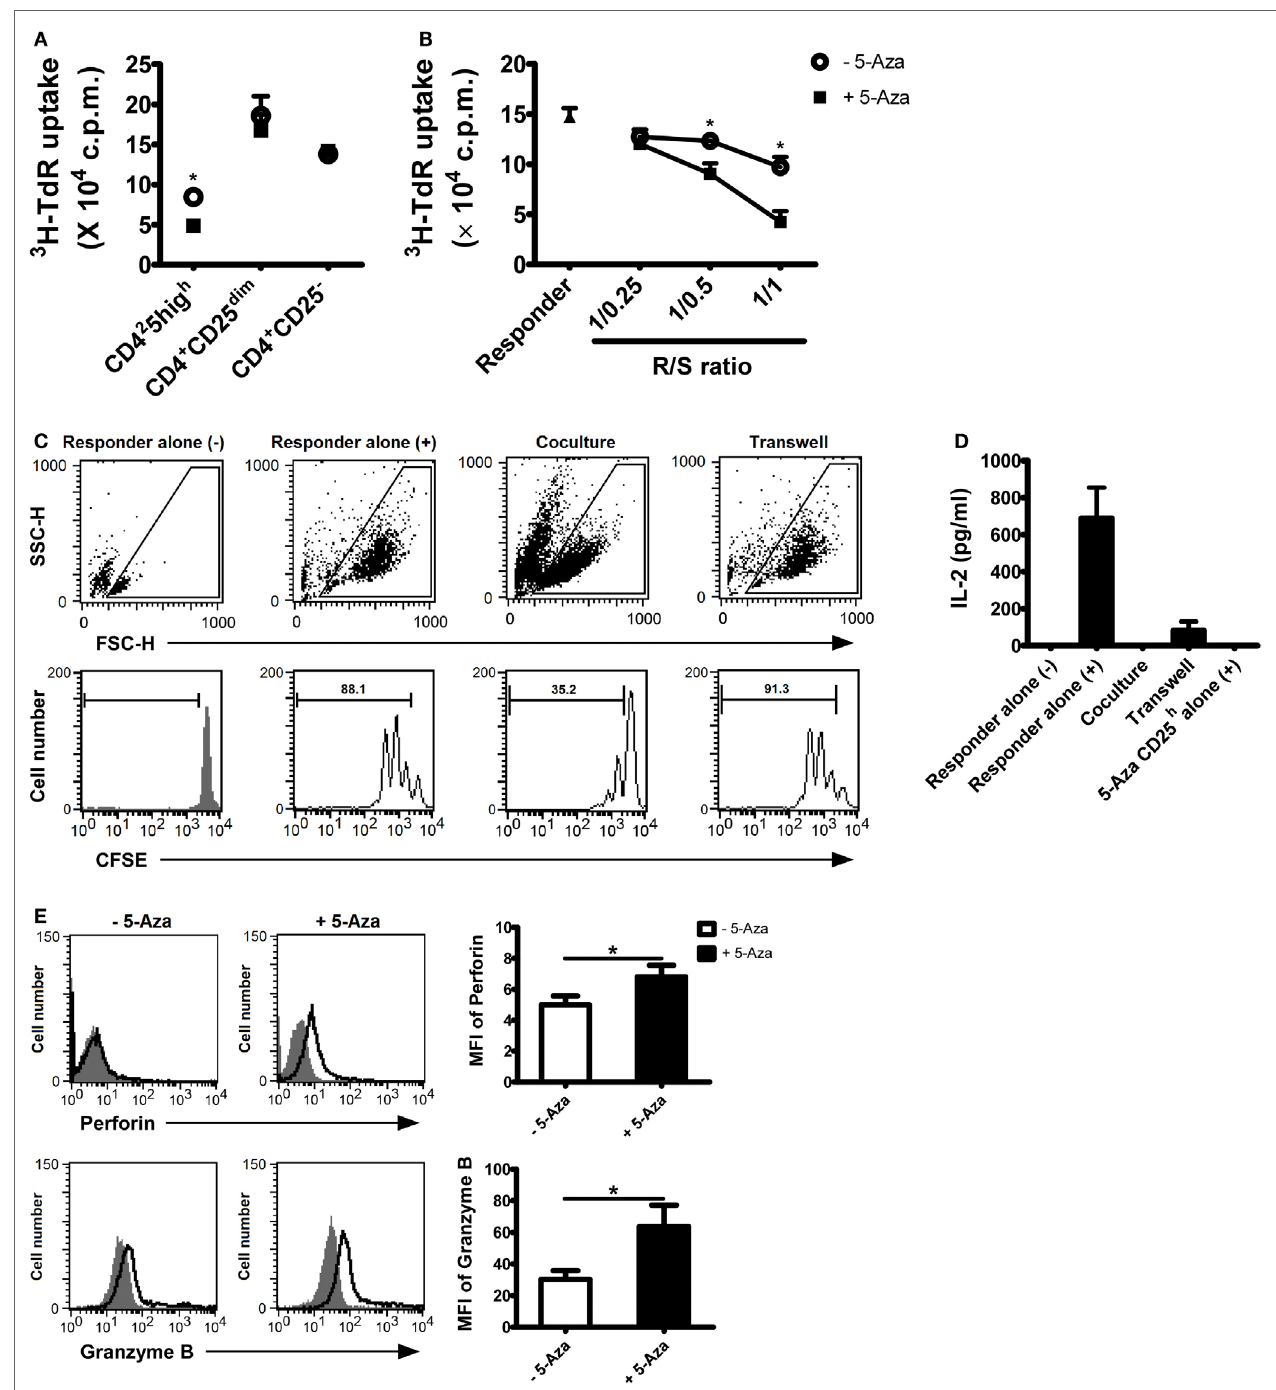
FigUre 2 | 5-aza-treated cD4 + cD25 h T cells were hyporesponsiveness to Tcr stimulation and demonstrated potent suppressive function . (a) After suboptimal TCR stimulation under the influence of 5-Aza, CD4 + CD25 h , CD4 + CD25 dim , and CD4 + CD25 − T cells were sorted by FACSAria. The different cell populations were restimulated with antibody-coated beads at a bead-to-cell ratio of 1:2 for 3 days. Proliferation was determined at day 3, with [ 3 H]-thymidine added for the last 16 h of culture. (B) Allogeneic CD4 + T cells (responder) were cocultured with CD4 + CD25 h T cells at the indicated ratios. Proliferation was also determined at day 3 with [ 3 H]-thymidine addition. (c,D) The responder was incubated with CFSE first and cocultured with 5-Aza-treated CD4 + CD25 h T cells for 3 days. ( – ) and ( + ) represent cells without activation and cells stimulated with activation beads, respectively. The results were analyzed by FACSCalibur. Supernatants were collected for IL-2 measurement by ELIA. (e) After suboptimal TCR stimulation under the influence of 5-Aza, CD25 highly expressing cells were gated to examine the expression of perforin and granzyme B by FACSCalibur. Data are representative of seven independent experiments and shown as the mean ± SD (* P <